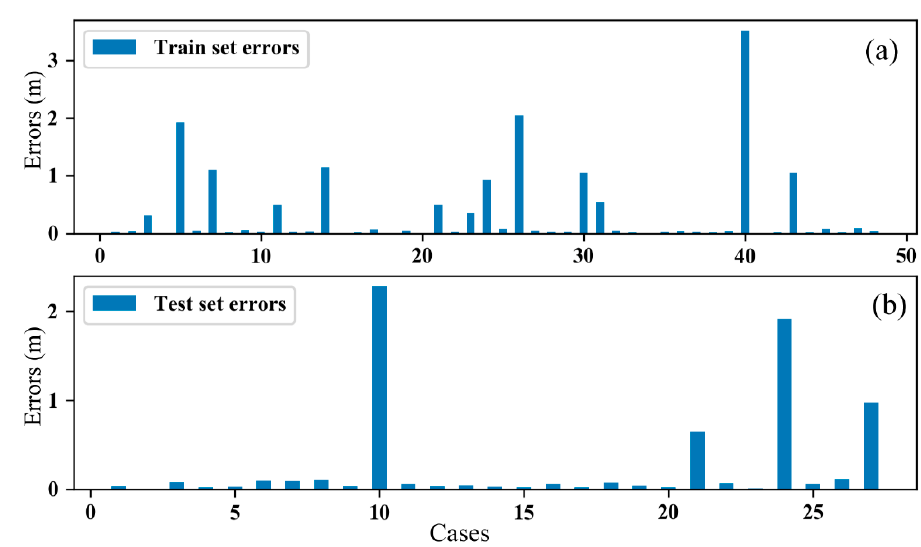
Figure 5. The absolute value of the error between predicted and real penetration depths of a gravity corer with machine learning models. The absolute error values were obtained by subtracting the predicted values from the true values and then taking the absolute value. ( a ) Errors of train set; ( b ) Errors of the test set.